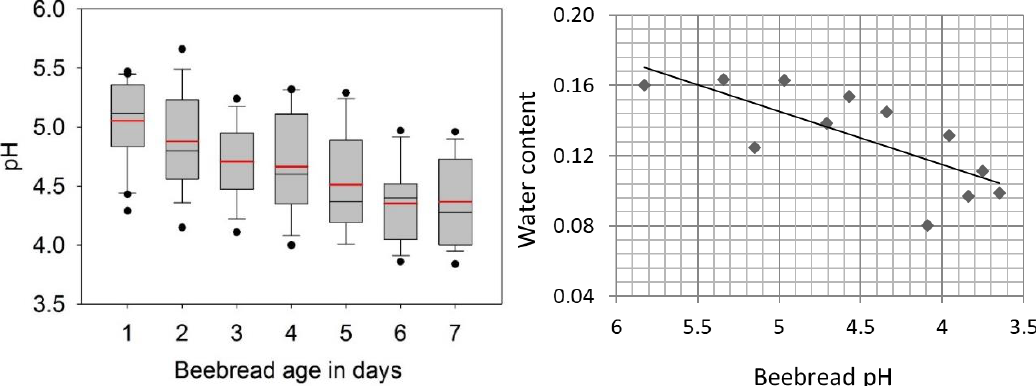
Figure 1. Abiotic factors associated with pollen storage that mitigate microbial growth. The figure on the left represents the variation in pH from stored pollen “beebread” from seven hives tracked by beebread age. The red line is the mean, black the median, boxes are at 25% and 75%, whiskers at 5% and 95%, and dots are outliers. Beebread pH decreased significantly over the seven-day period following pollen collection by foragers. The panel on the right is a subset of beebread samples that represent variation in pH and its relationship to water availability. The proportion of water available in beebread decreased significantly as a function of storage time and decreasing pH.